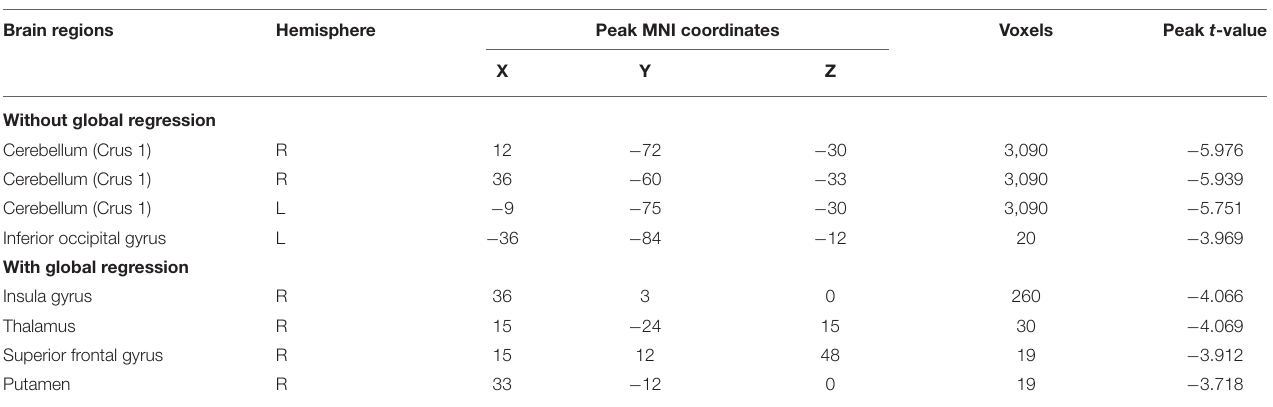
TABLE 4 | Between-group comparison on global signal FC. Brain